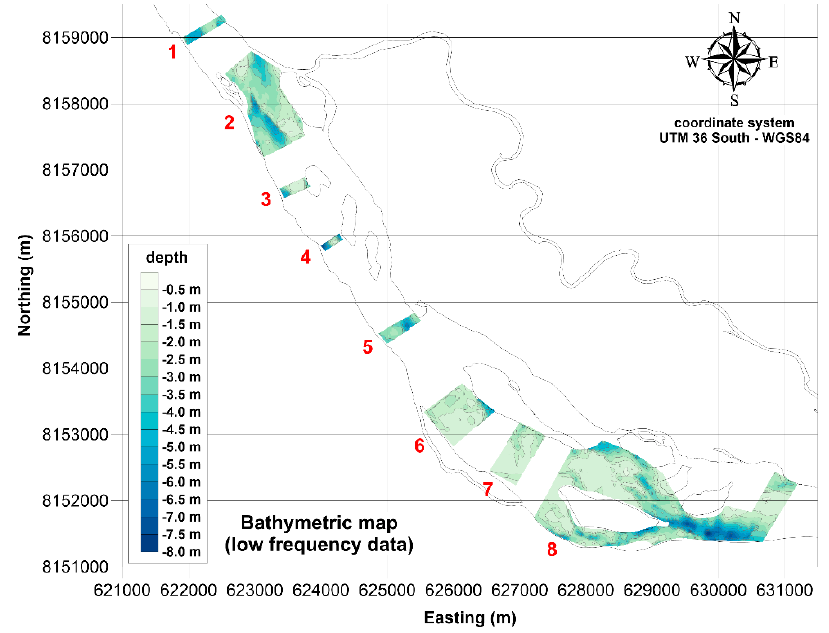
Figure 7. Bathymetric map of surveyed area, derived from low frequency data (24 kHz).